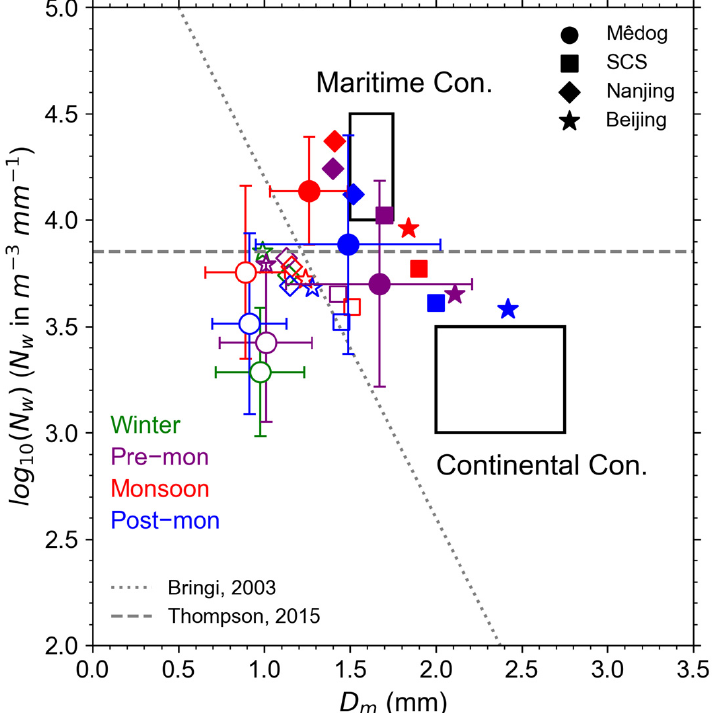
Figure 10. Scatterplots of averaged log 10 ( N w ) versus D m (along with ± σ standard deviation bars) for stratiform (blank symbols) and convective (full symbols) precipitation in Mêdog (circles), SCS (squares), Nanjing (diamond) and Beijing (star) during the winter (green), premonsoon (purple), monsoon (red) and postmonsoon (blue) seasons. The two outlined squares represent (left) the maritime and (right) continental types of convective systems reported by Bringi et al. [34]. The dotted line and dashed lines represent the C–S separation line by Bringi et al. [34] and Thompson et al. [5].